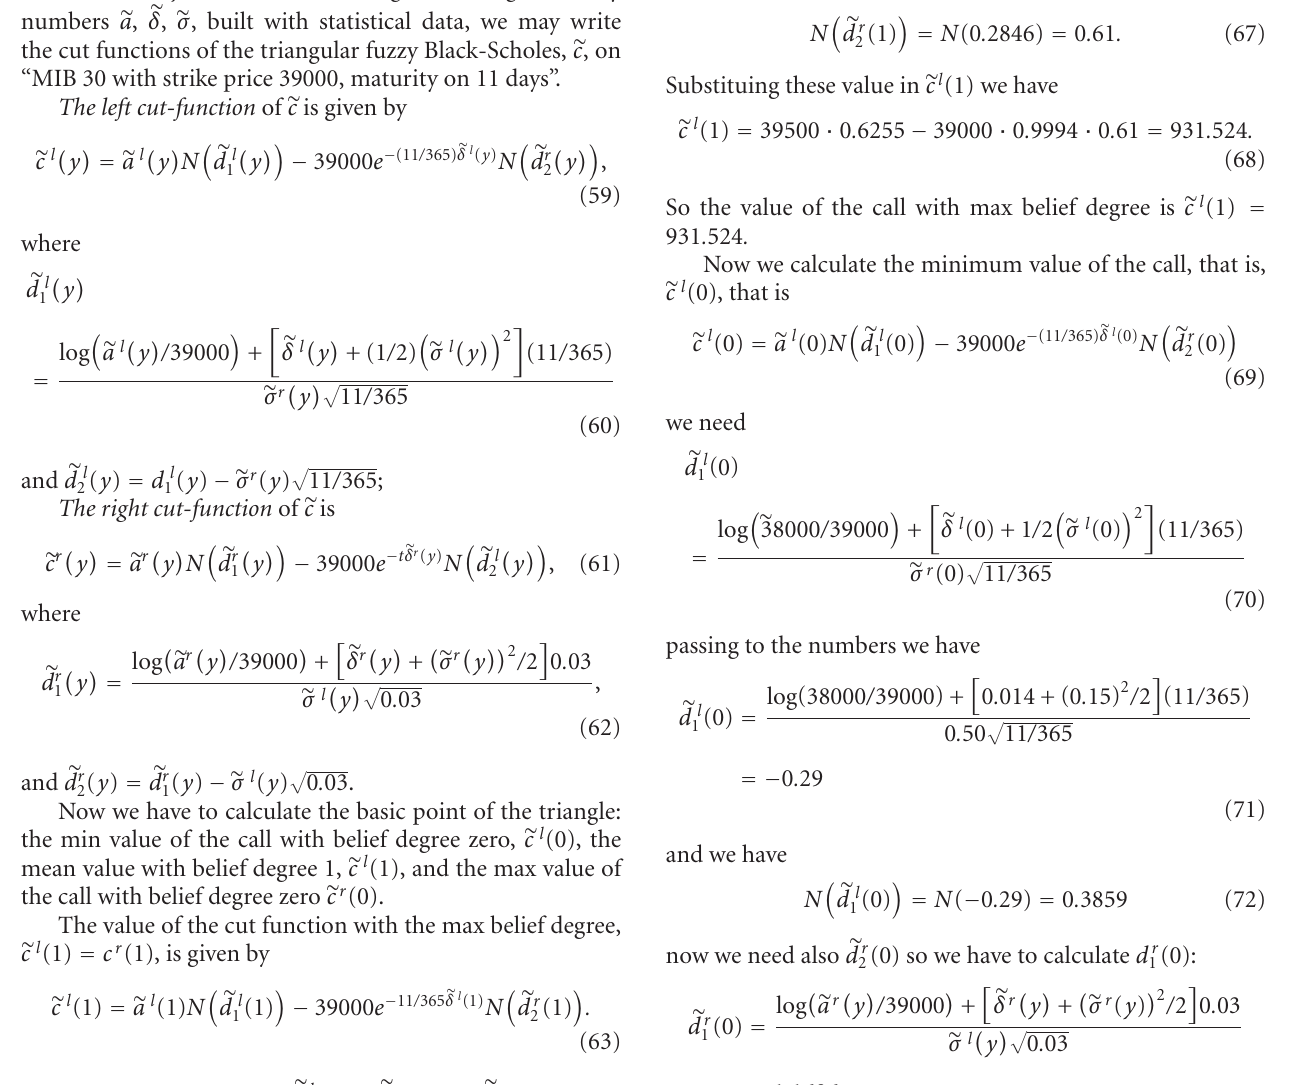
Statistical Fuzzy Black-Scholes. Using the triangular